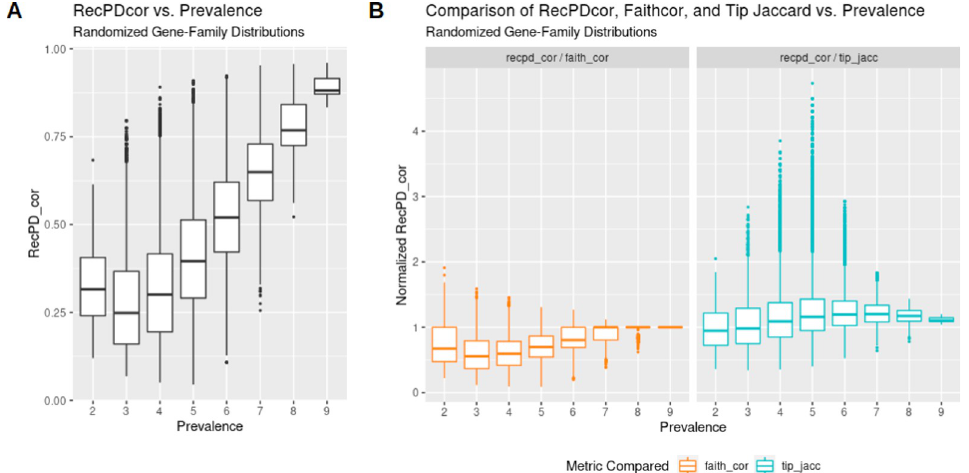
Fig 4. Pairwise gene family evolutionary history correlations using RecPDcor differ in comparison to recombination-agnostic and phylogeny-agnostic approaches. (A) RecPD correlation (RecPDcor) values for randomized gene family distributions vs. prevalence reveals that the majority of low-prevalence trait distributions have distinct evolutionary histories; (B) RecPDcor of trait distributions substantially differs when compared to 1) Faith’s PD based branch-length weighted Jaccard similarity (recombination-agnostic), and 2) tip presence and absence Jaccard similarity (phylogeny-agnostic) measures: 1) Ignoring recombination results in over-estimation of low-prevalence feature evolutionary history correlations (RecPDcor / Faith’s PD < 1); 2) Ignoring evolutionary history results in under- estimation of intermediate-prevalence feature evolutionary history correlations (tip_jacc / RecPDcor >